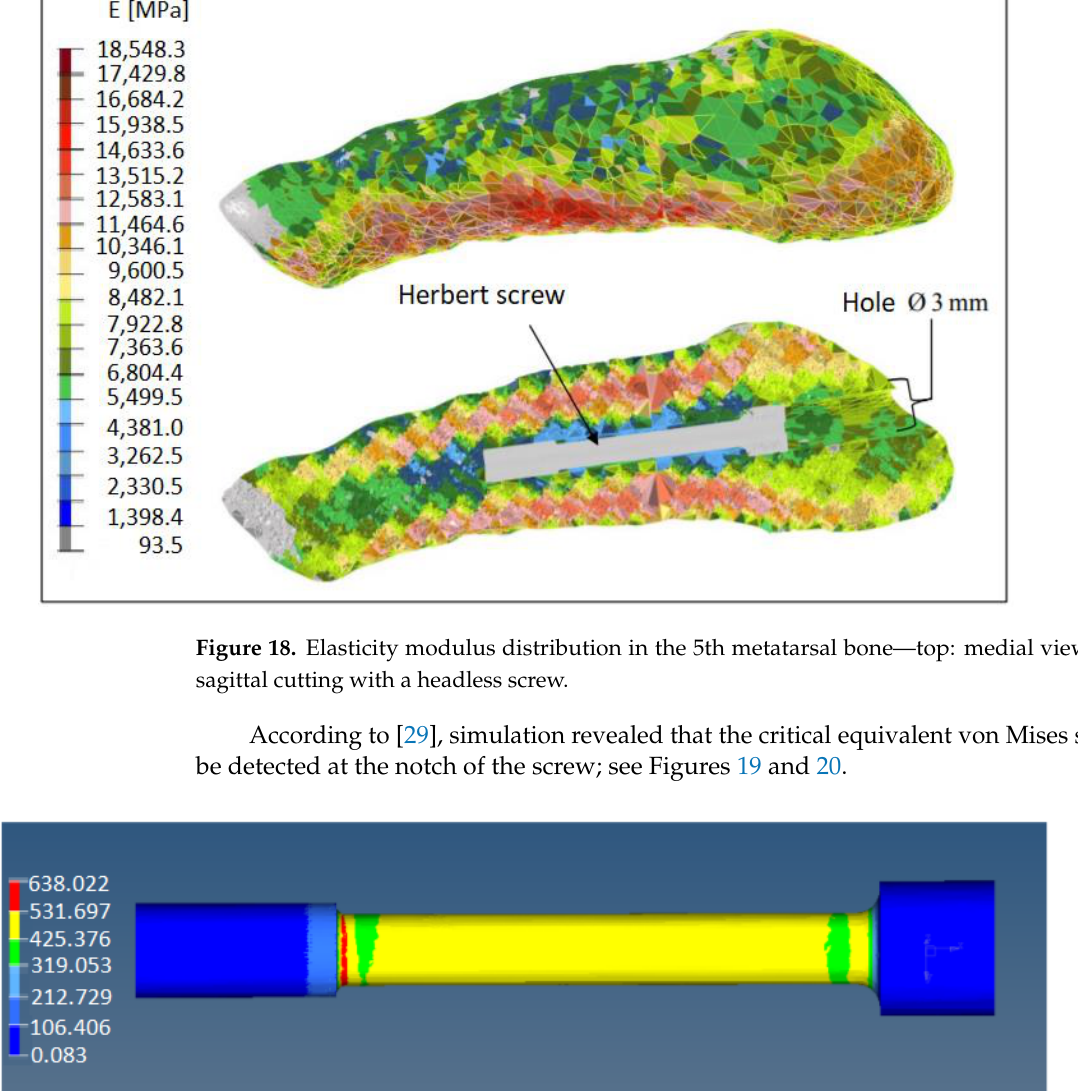
Figure 19. Critical von Mises stress in a headless screw in the 5th metatarsal.